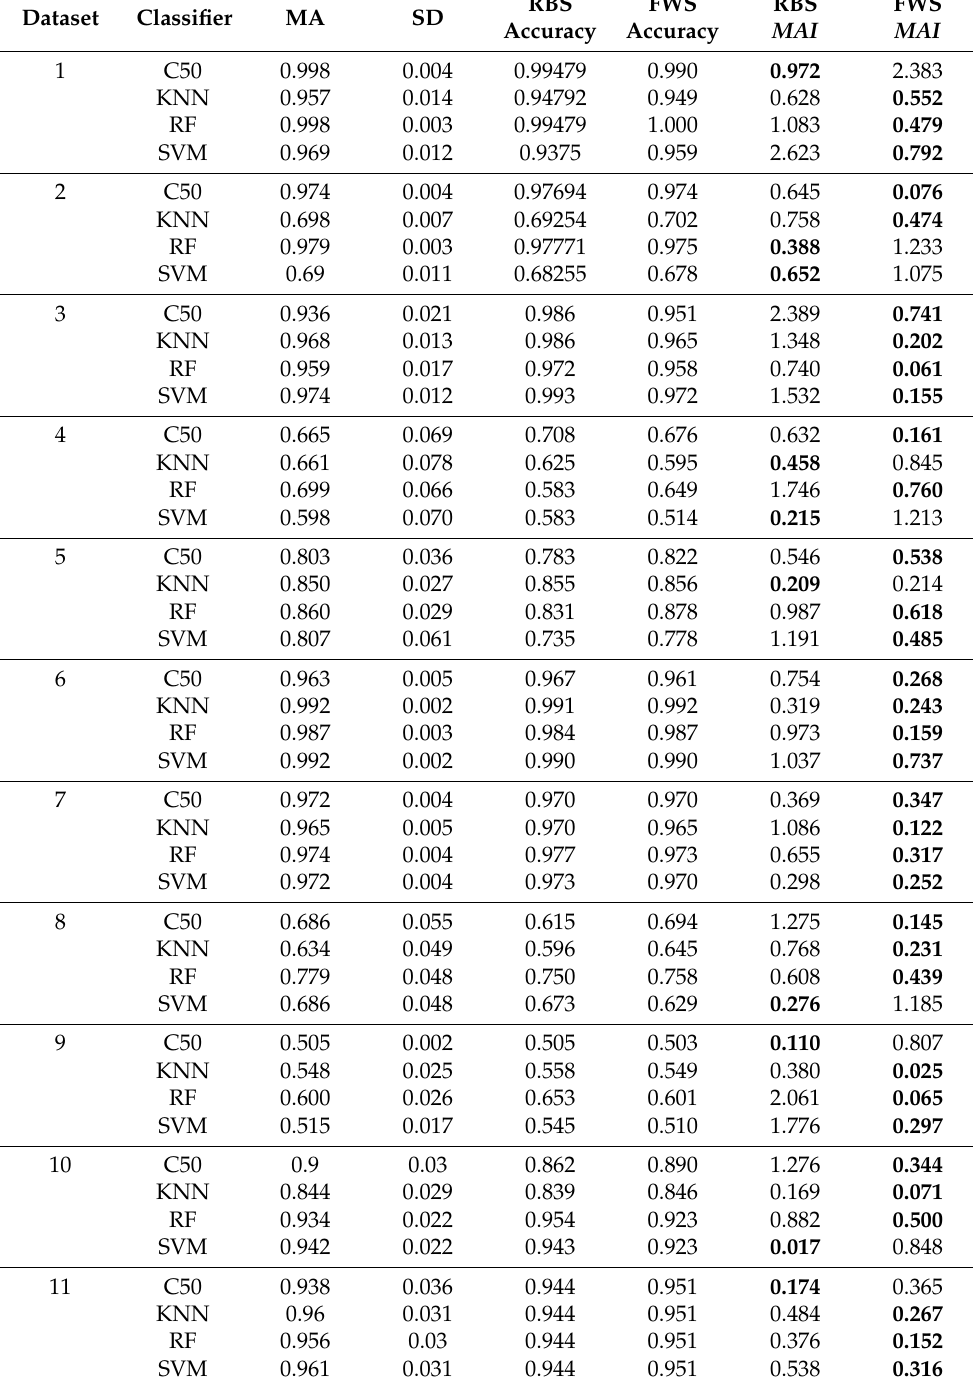
Table 3. Final experimental